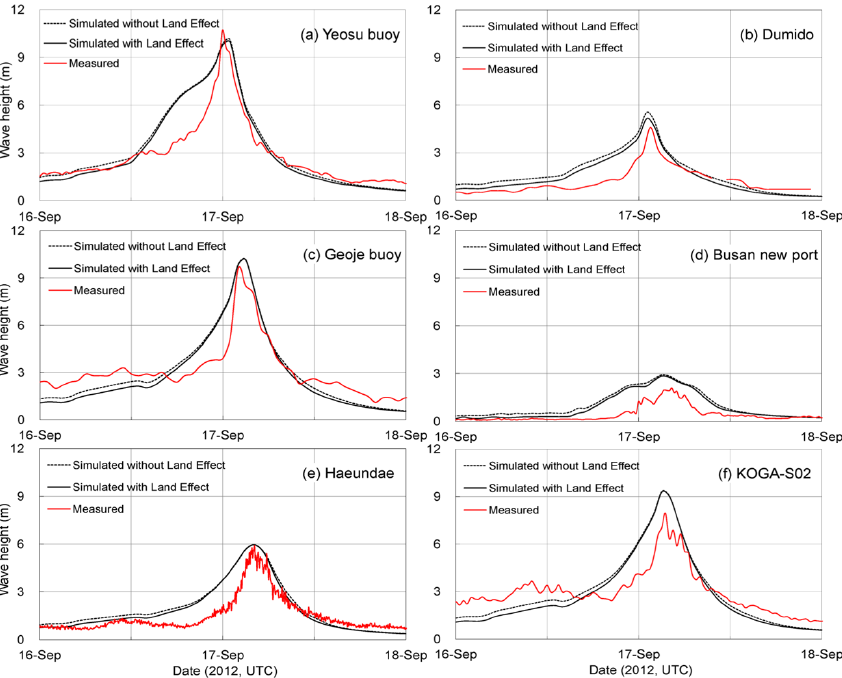
Figure 13. Simulated (Case 3 and Case 4) and observed wave heights during typhoon Sanba ( (a) Yeosu buoy; (b) Dumido; (c) Geoje buoy; (d) Busan new port; (e) Haeundae; (f) KOGA-S02).